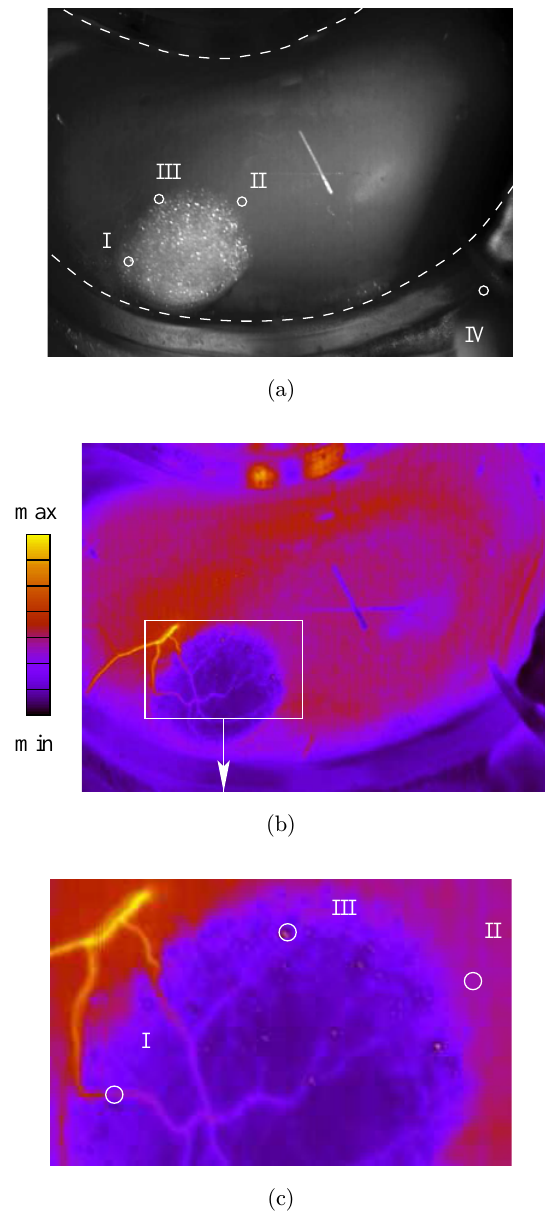
Fig. 4. Experimental data on kidney blood °ow. (a) Optical image of rat's kidney (outlined by dashes) with marked points of interest. (b) Blood perfusion image, estimated from LSI and averaged over 44 min. (c) Close up on the rectangle in